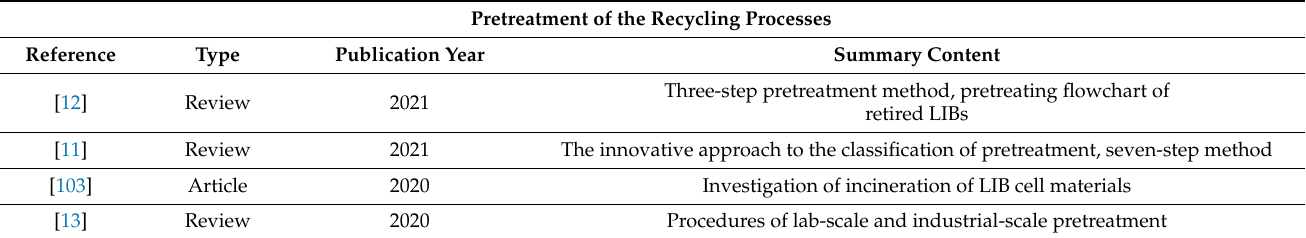
Table A1. Assessed literature in review for “Pretreatment”